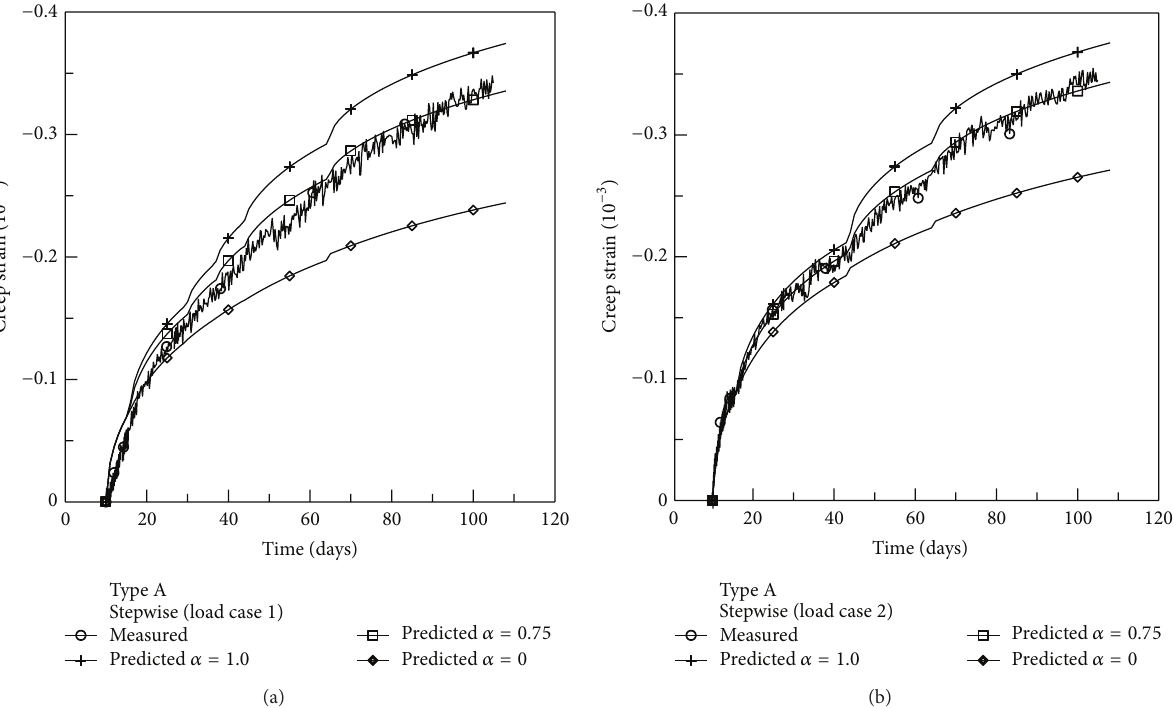
Figure 7: Predicted and measured creep strains for the two stepwise load cases of type A test: (a) load case 1 and (b) load case 2.